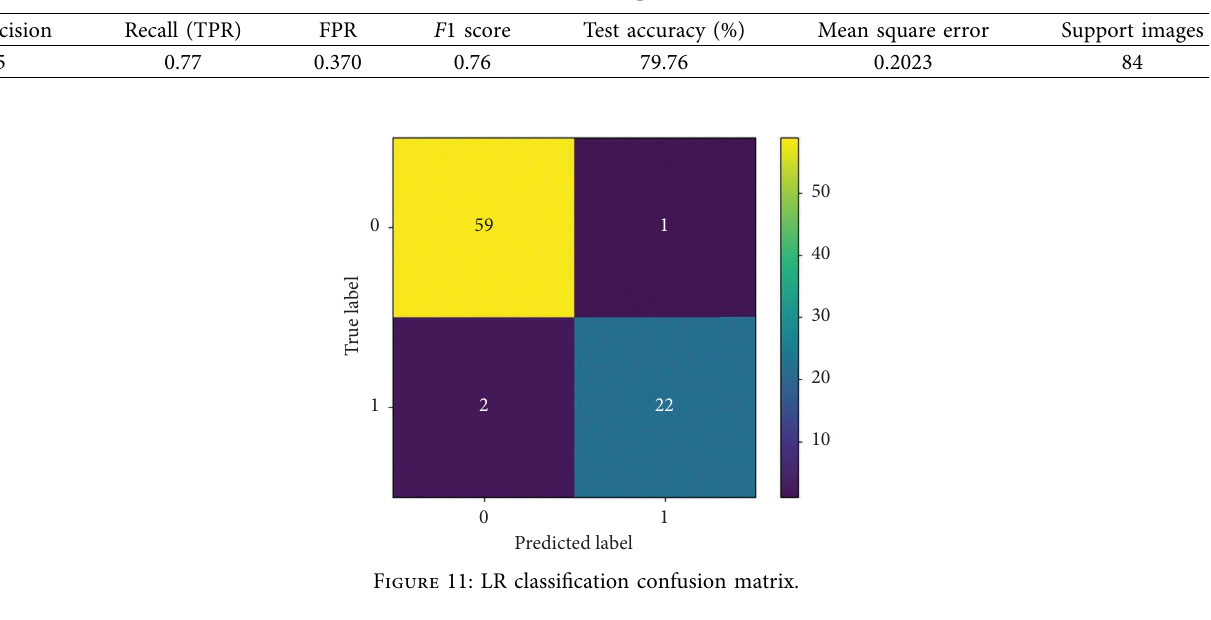
Figure 10: J48 classifcation confusion matrix. Table 3: J48 classifer parameters.